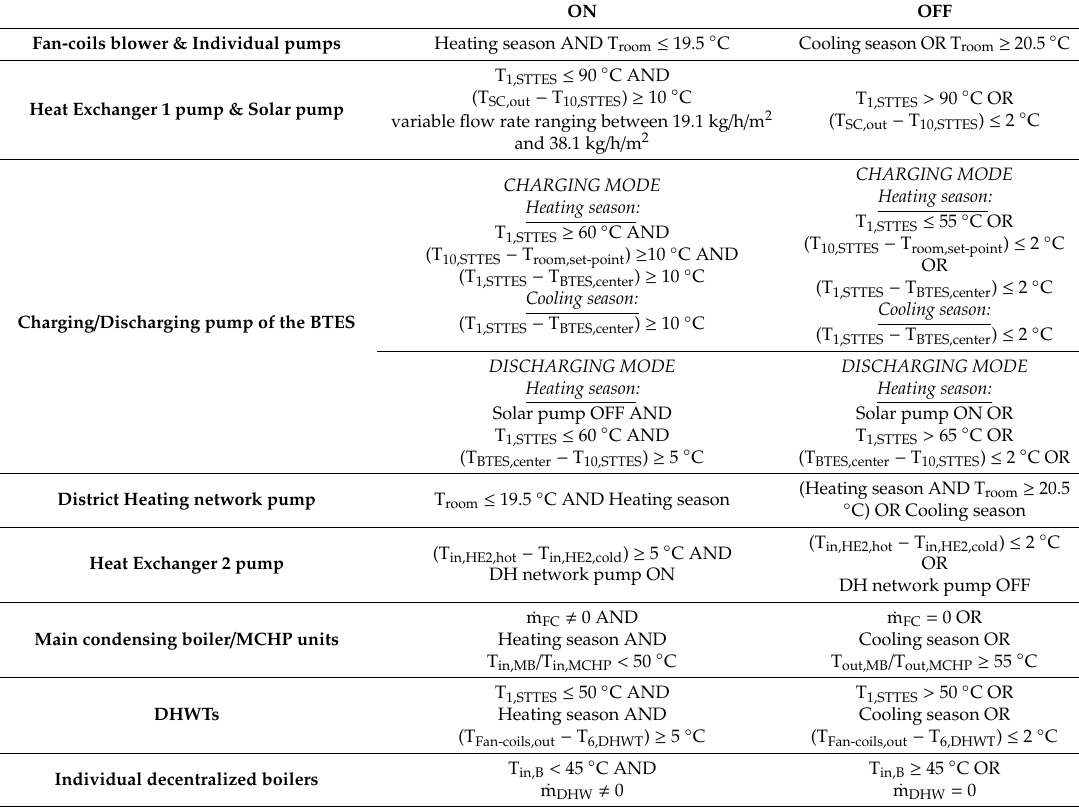
Table 5. Control logics of the investigated